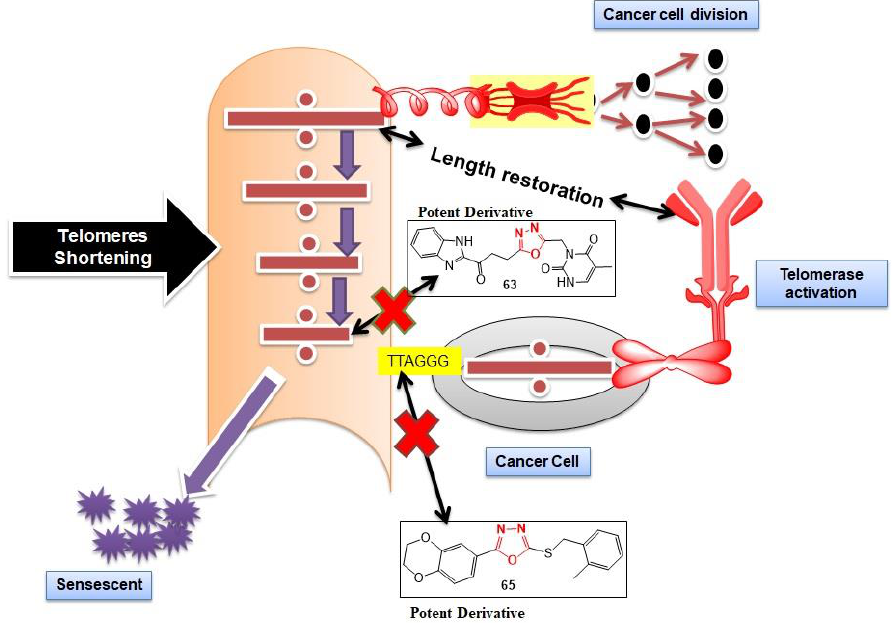
Figure 8. Telomerase enzyme and its inhibitors .